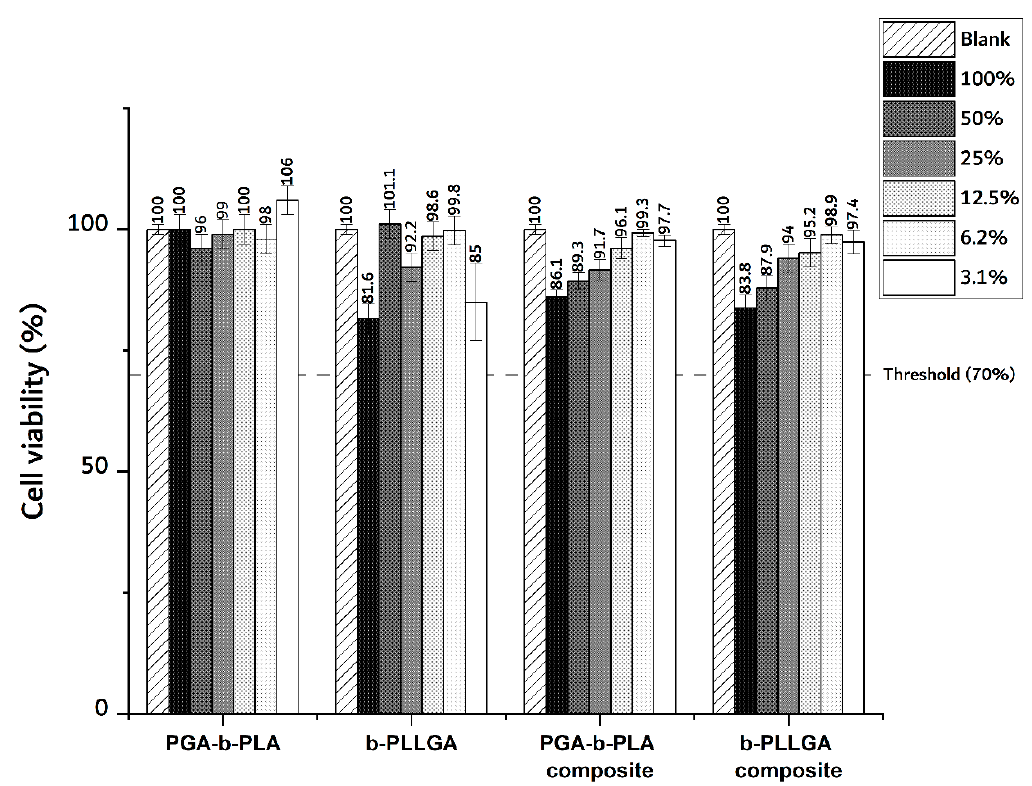
Figure 5. MTT assay of the PGA–b-PLA, b-PLLGA, the PGA–b-PLA composite, and the b-PLLGA composite (sample eluted in DMEM, n = 4).